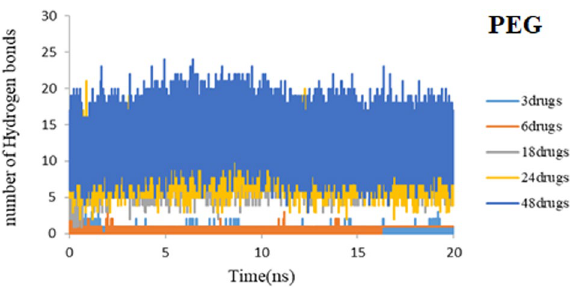
Figure 20. Number of hydrogen bonds between 3TC molecule and PEG during simulation